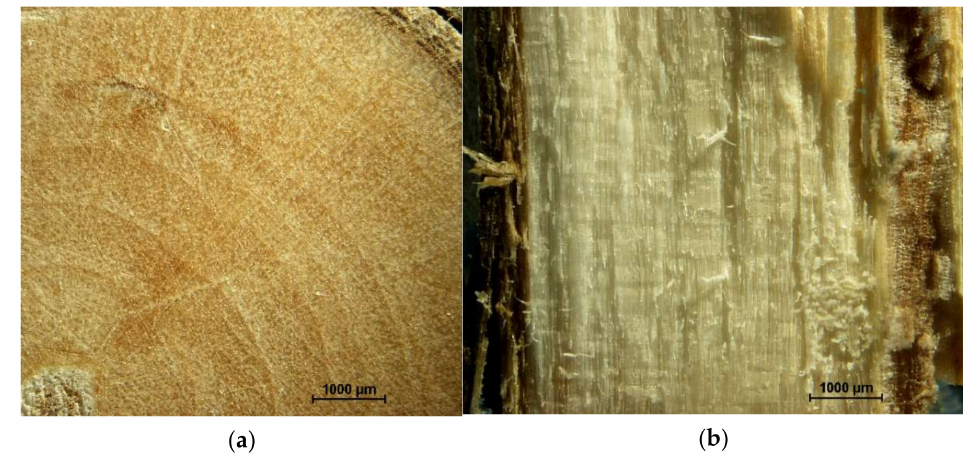
Figure 3. Cross-cut: ( a ) across and ( b ) along the fiber of the chokeberry stalk.